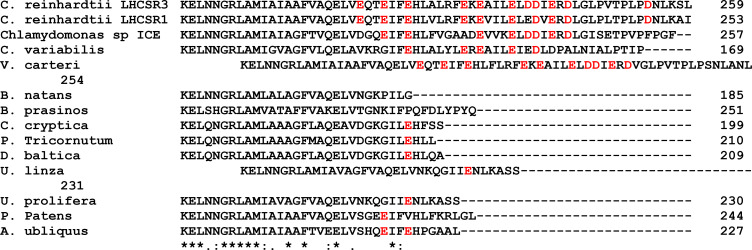
Alignment of LHCSR-like proteins: protonatable residues are red written while insertion site for TAA mutation to generate the stop-LHCSR3 mutant is indicated by black arrow.Protein number for LHCSR-like proteins used for alignment are listed below: XP_001696064.1 Chlamydomonas reinhardtii LHCSR3, XP_001696125.1 Chlamydomonas reinhardtii LHCSR1, XP_002948670.1 Volvox carteri f. nagariensis, ADP89594.1 Chlamydomonas sp. ICE-L LHCSR2, XP_001768071.1 Physcomitrella patens LHCSR2, ABD58893.1 Acutodesmus obliquus, ADY38581.1 Ulva linza, ADU04518.1 Ulva prolifera, XP_005848576.1 Chlorella variabilis, XP_002178699.1 Phaeodactylum tricornutum, AHH80644.1 Durinskia baltica, AA05890.1 Bigelowiella natans, CCO66741.1 Bathycoccus prasinos.